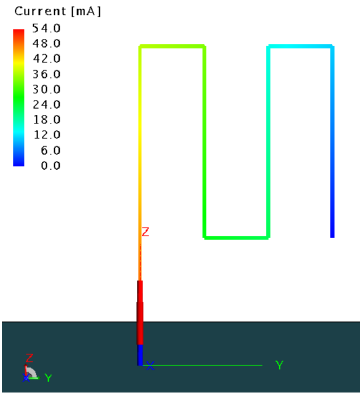
Figure 9. Segment currents of TF model